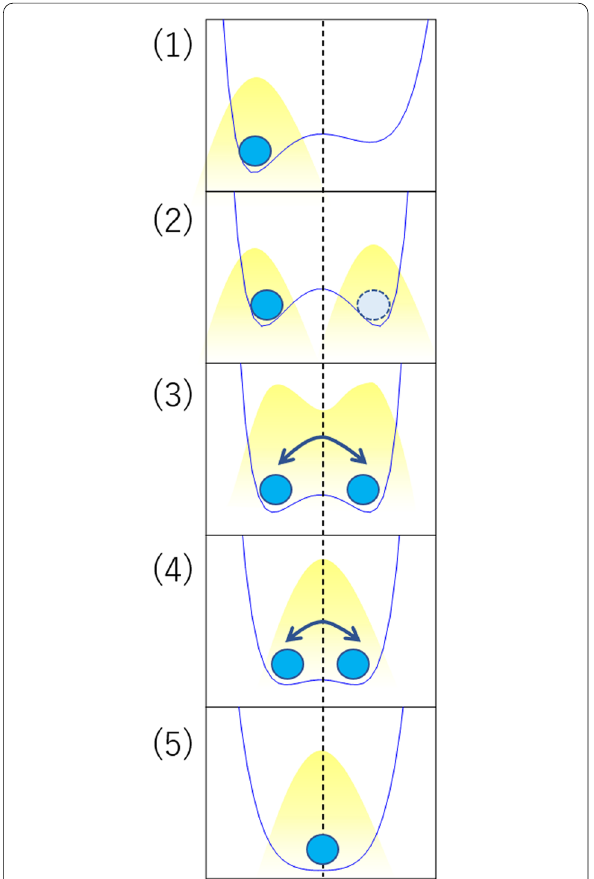
Fig. 3 Schematic illustration of proton distributions of the hydrogen bond in ice VIII/VII/X under pressure. (1) asymmetric hydrogen bond, (2) static disordering, hydrogen resides at one of double potential wells, (3) dynamical disordering with bimodal probability of proton (e.g., dynamically disordered ice VII) (4) dynamical disordering state with unimodal probability of proton at the midpoint of two oxygen atoms (dynamically disordered ice X), (5) symmetric hydrogen bond (ice